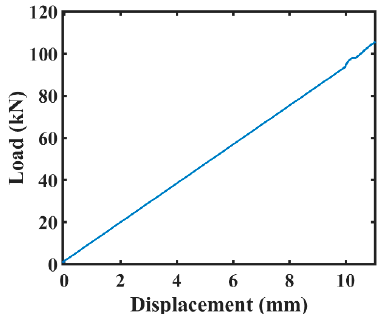
Figure 4. Collected noisy AE signals from the three-point bending test: ( a ) normal condition and ( b ) abnormal condition.